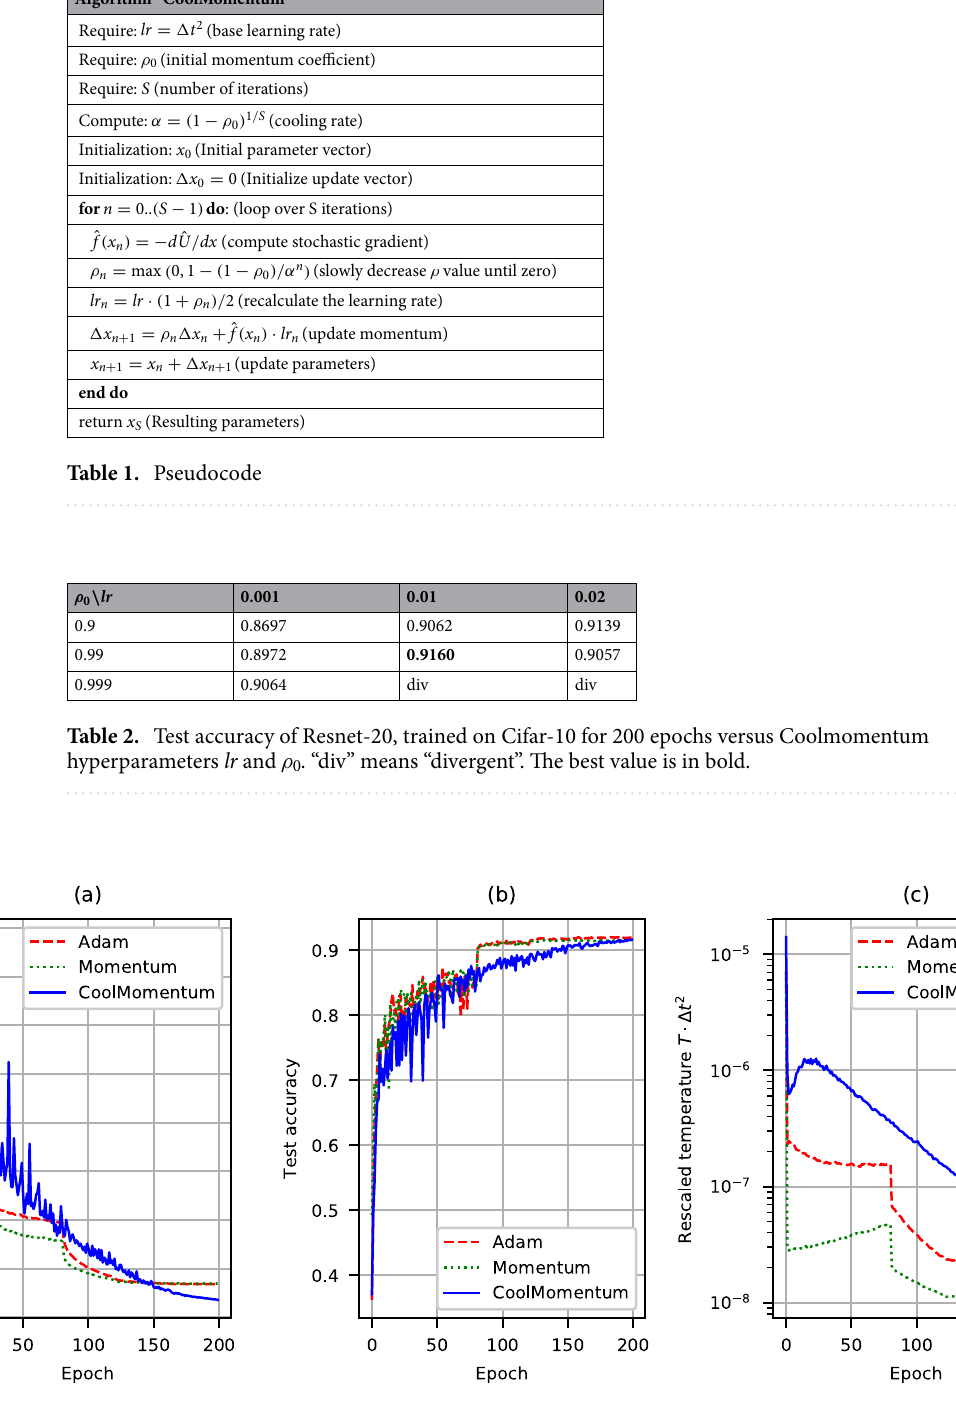
Figure 1. Cifar-10 classification with ResNet-20: training loss ( a ), test accuracy ( b ) and rescaled temperature 2 ( T · (cid:31) t ) ( c ).